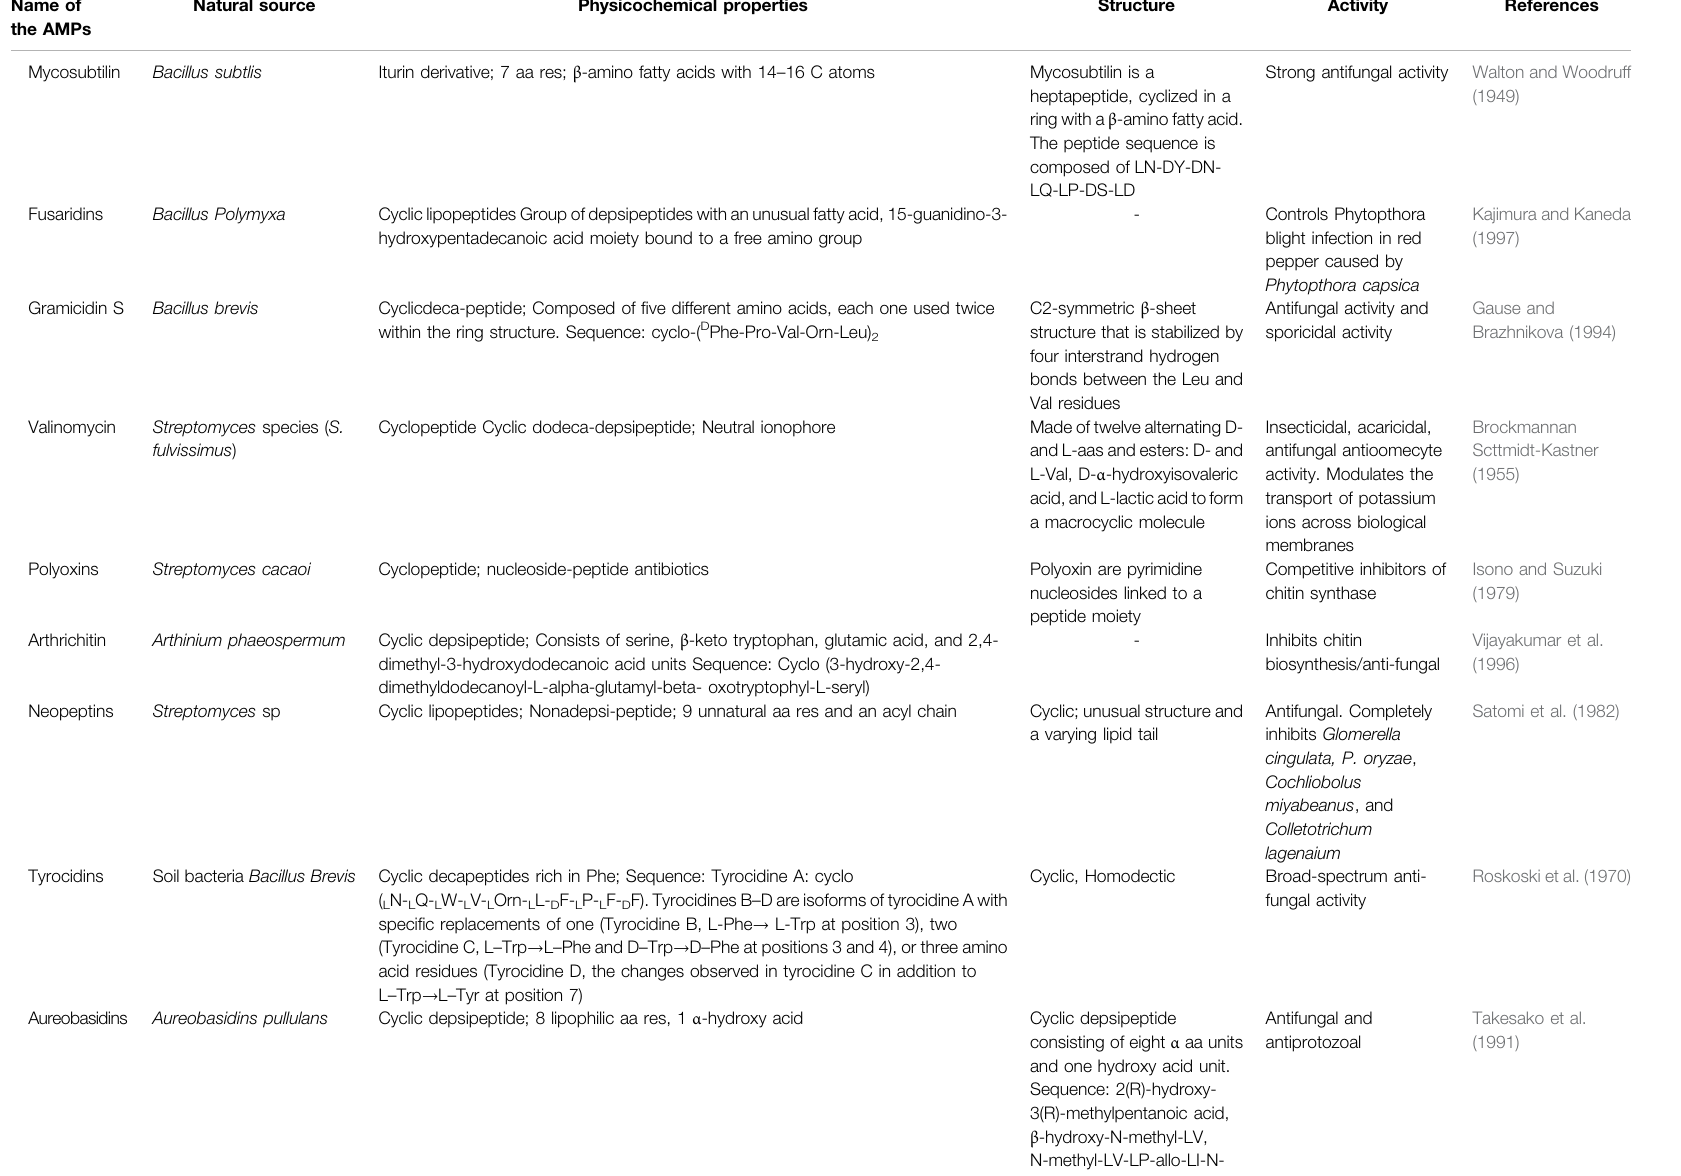
TABLE 1 | ( Continued ) Natural antimicrobial peptides (aa (cid:1) amino acid; res (cid:1)